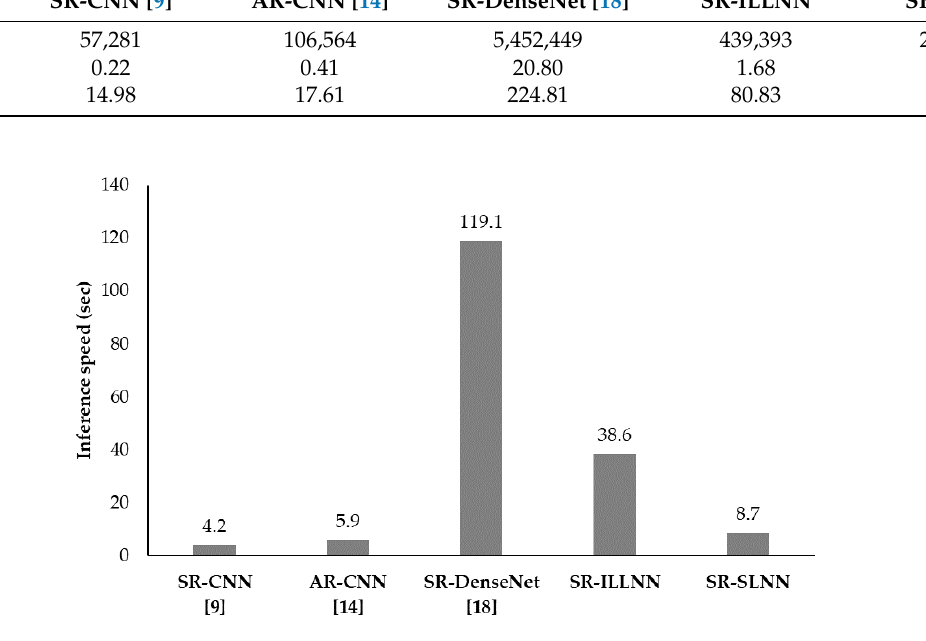
Figure 8. Inference speed on BSD100.